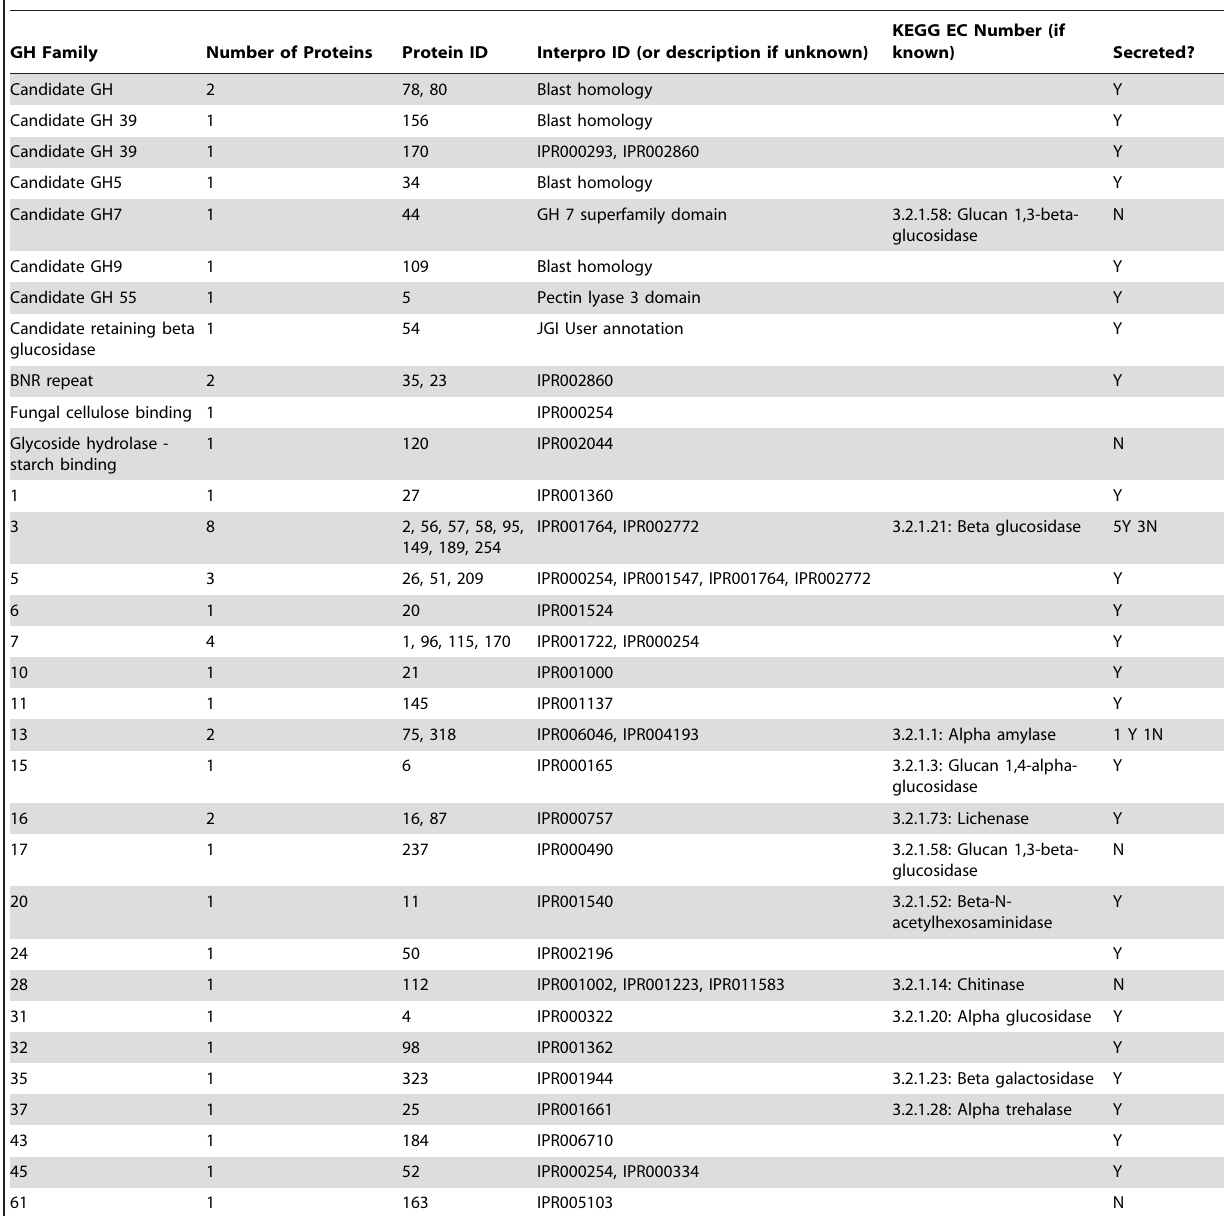
Table 3. Glycoside hydrolase (GH) families detected in MudPIT